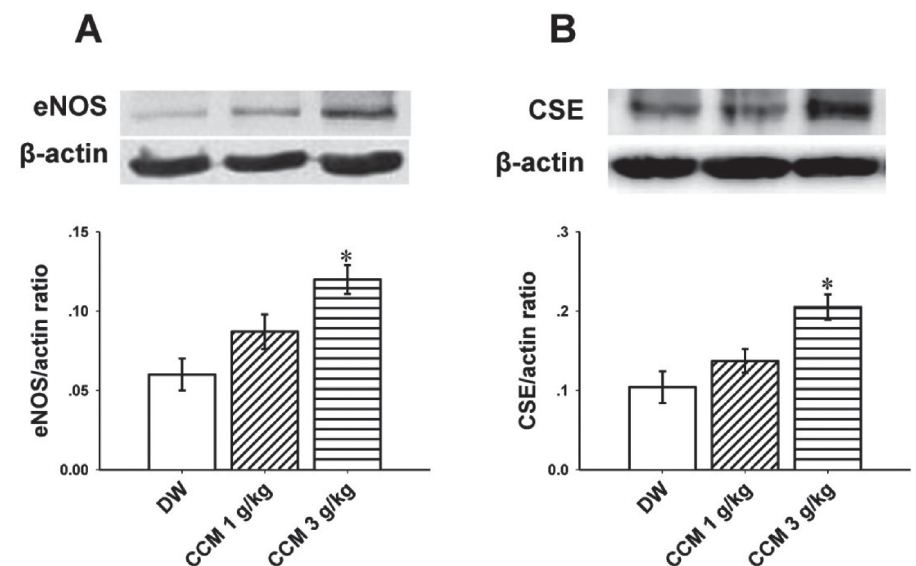
FIGURE 6 - The effect of 6 weeks oral administration of CCM (1 or 3 g/kg) or distilled water on eNOS (A) and CSE (B) protein expression of the thoracic aorta compared to a distilled water control group (DW). For each blot, β-actin expression is shown as a loading control. Values represent as mean ± SEM; n=4. *Significantly higher than the other groups, P<